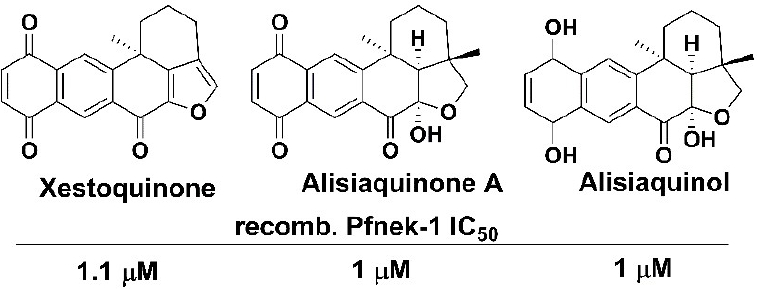
Figure 6. Quinone-based inhibitors of Pfnek-1 enzyme, derived from the deep-water marine sponge Xestospongia sp.